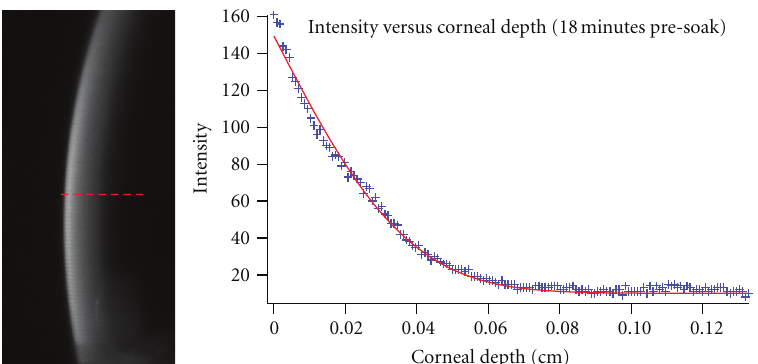
Figure 4: The image on the left shows the intensity profile after 18 minutes of presoak with 0.1% riboflavin in 20% dextran. The corresponding plot on the right shows the intensity versus the corneal depth (blue marker) and the curve fit to the experimental data (red